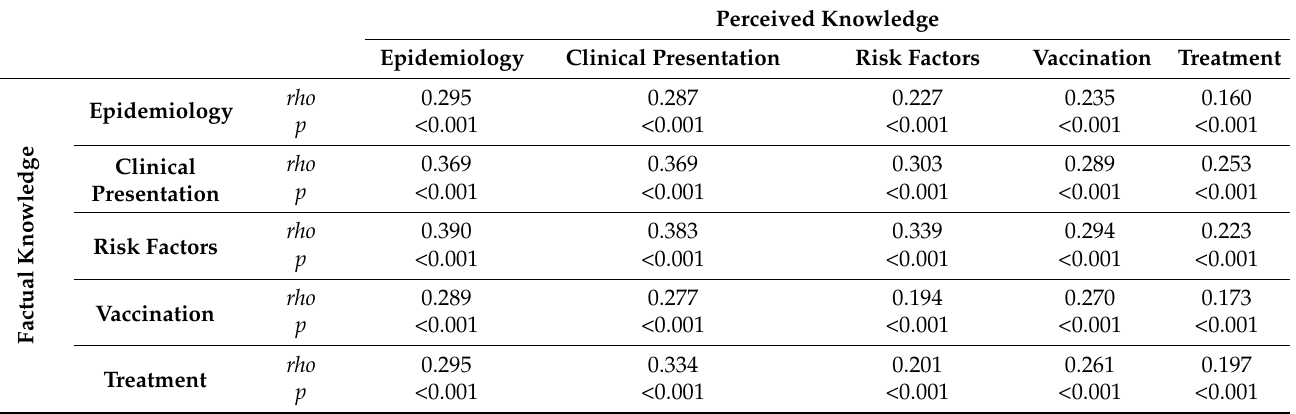
Table 5. Correlation between perceived and factual knowledge of Czech HCWs responding to the HMPXV survey, September 2022 ( n =